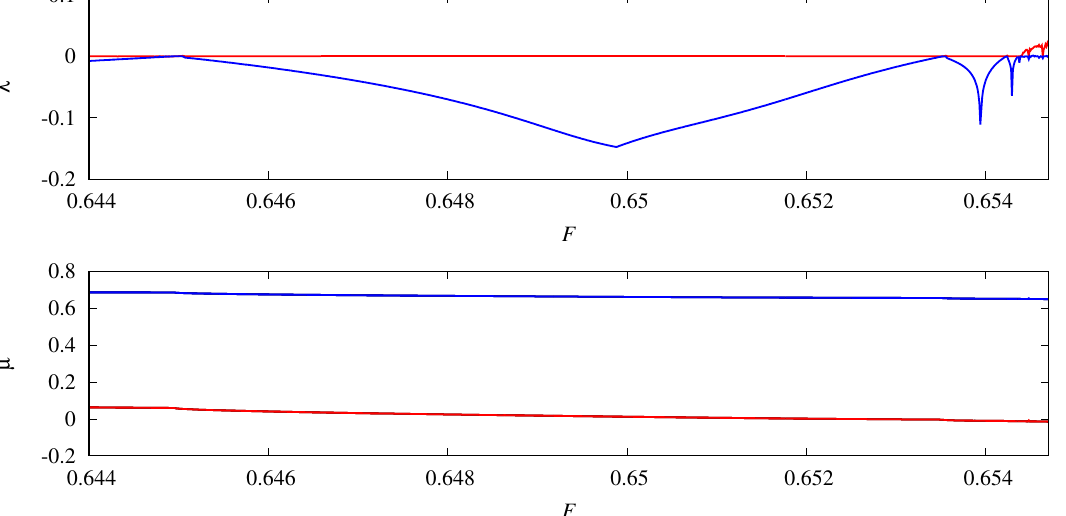
Figure 7. As Figure 4, but for dimension n = 6. Period doubling bifurcations take place for parameter values where the second Lyapunov exponent λ 2 equals zero. Observe that the number of coexisting attractors remains the same across this range of